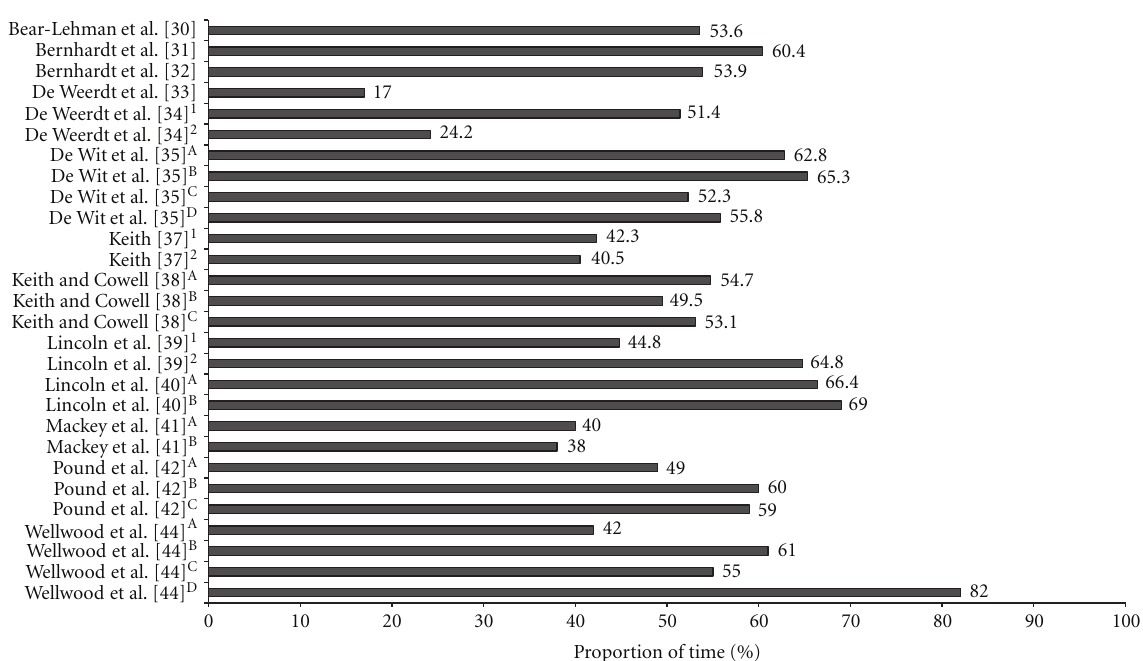
Figure 2: Proportion of time spent alone. 1 and 2 denote di ff erent time periods of observation; A, B, C, and D denote di ff erent hospital